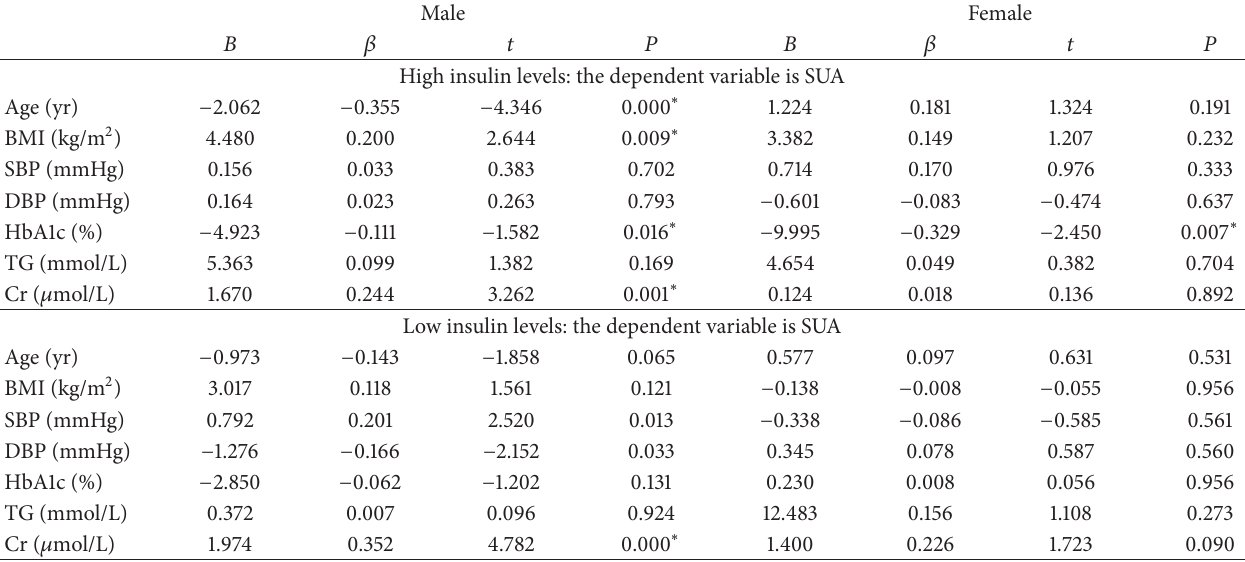
Table 4: Multiple linear regression for SUA and HbA1c in patients with high and low insulin levels. Male Female 𝐵 𝛽 𝑡 𝑃 𝑃 High insulin levels: the dependent variable is